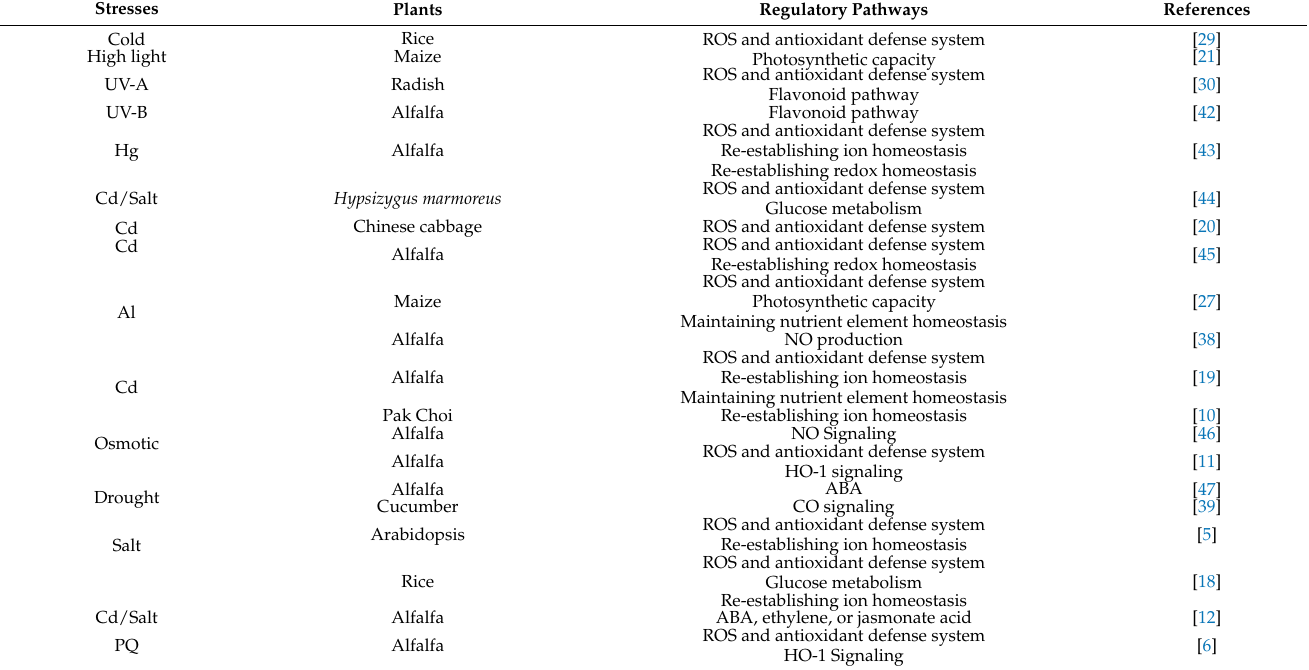
Table 1. Overview of the abiotic stresses alleviated by H 2 and regulatory pathways involved in the process in